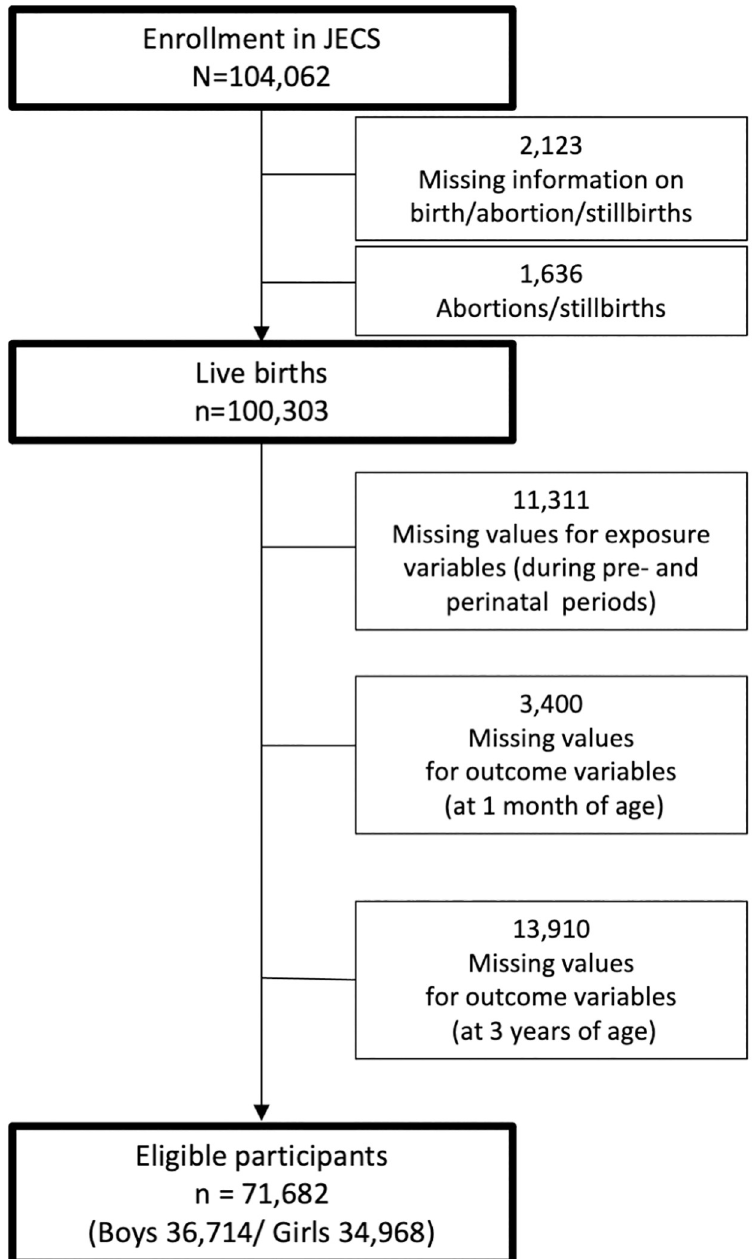
Fig 1. Flow diagram showing enrolment of eligible children from among the Japan Environment and Children’s Study (JECS) participants.